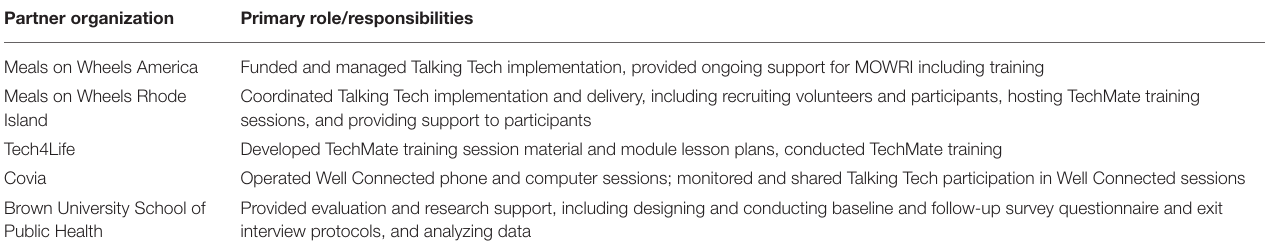
TABLE 1 | Intervention partner roles and